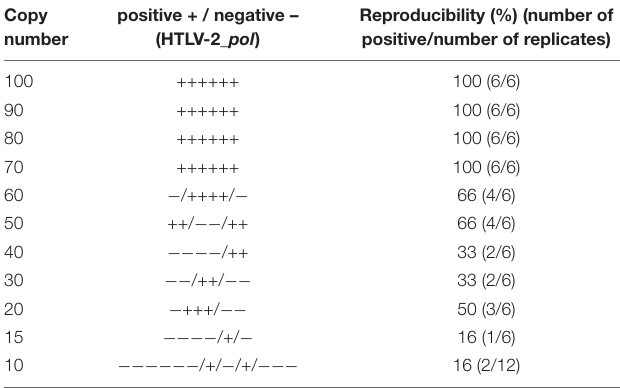
TABLE 2 | Efficiency of the mqPCR_HTLV ( pol and tax ), slope and correlation coefficients ( R 2 ) for detecting HTLV-1 and HTLV-2 using two platform/equipment. gene HTLV-1 HTLV-2